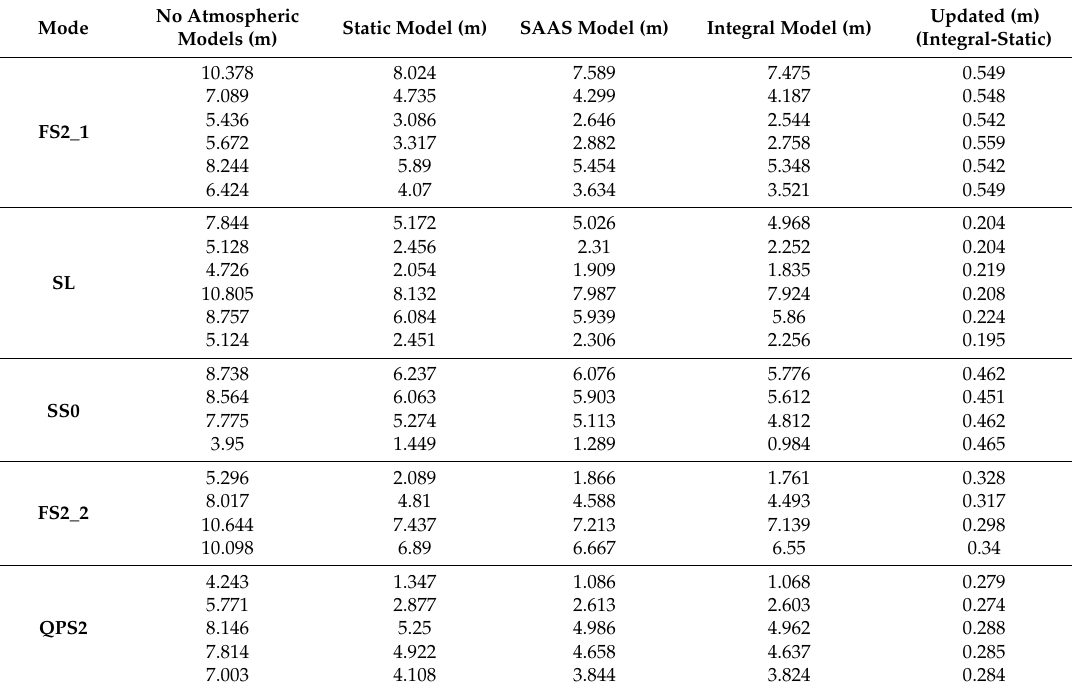
Table 3. The geolocation accuracy in range of the three tropospheric